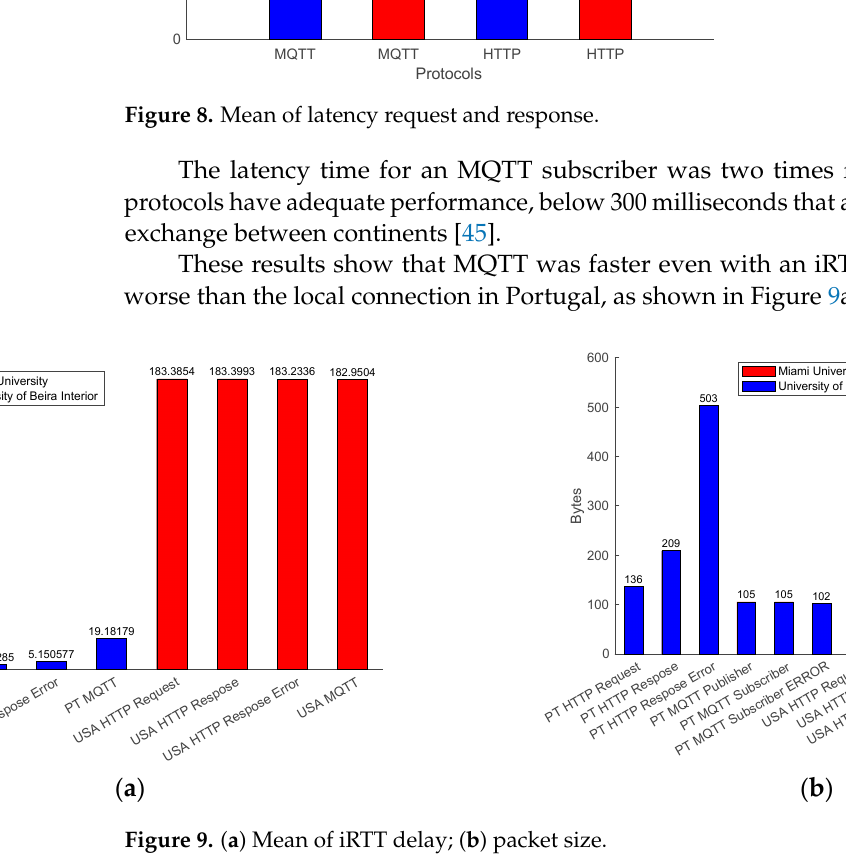
Figure 8. Mean of latency request and response.